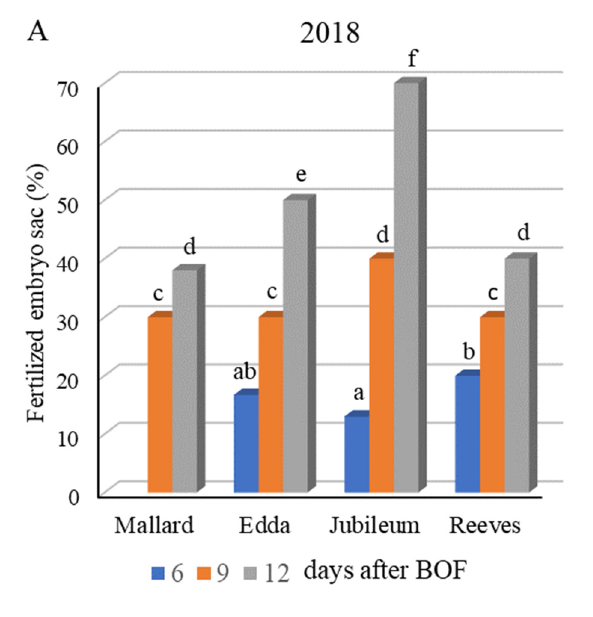
Figure 3. Regression analysis of embryo sac viability (%) in unpollinated flowers at the BOF, and on the 3rd, 6th, 9th, and 12th days after BOF in the plum cultivars ‘Mallard’, ‘Edda’, ‘Jubileum’, and ‘Reeves’ during 2018 and 2019.